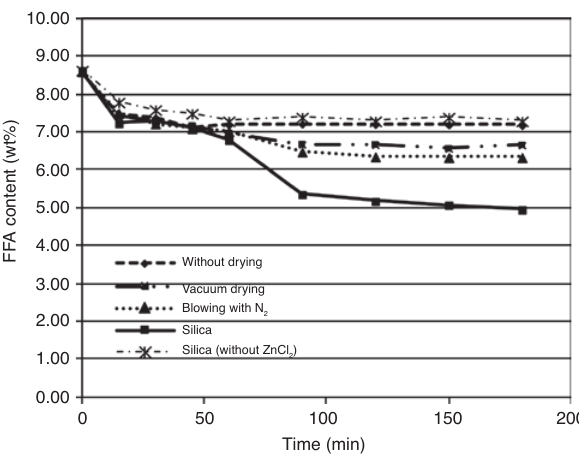
Figure 2: Influence of water removal methods on free fatty acid (FFA) reduction (T = 170 ° C, p = 3 bar, oil:glycerol mass ratio =